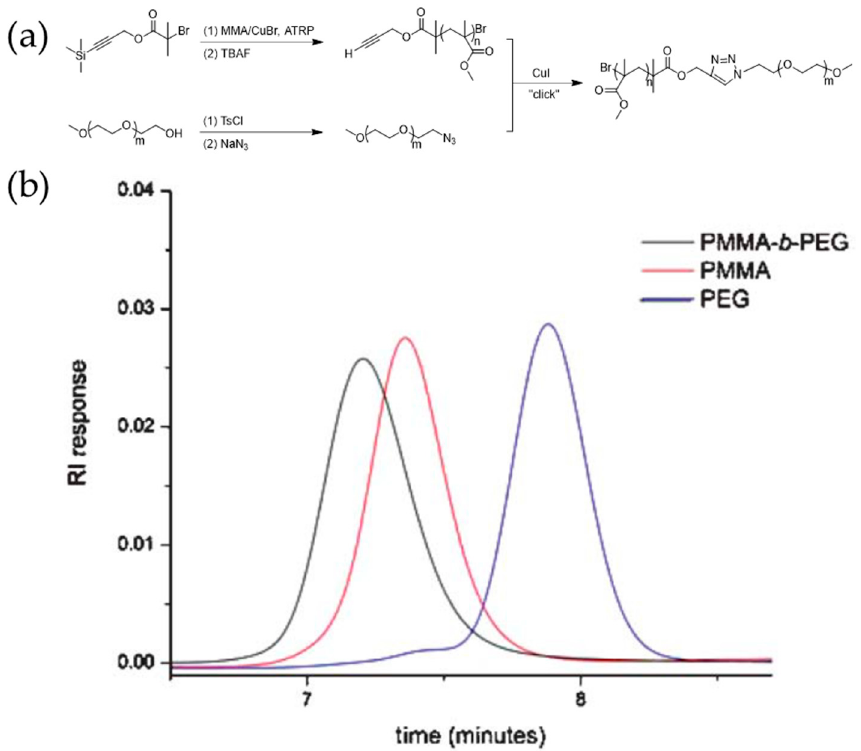
Figure 4. ( a ) Preparation of PMMA- b -PEG block copolymer via ATRP and azide-alkyne click reaction. ( b ) Size exclusion chromatography (SEC) curves of PMMA, polyethylene glycol (PEG), and PMMA- b -PEG diblock copolymer. Reprinted from Reference [57]. (Copyright (2005) Royal Society of Chemistry).